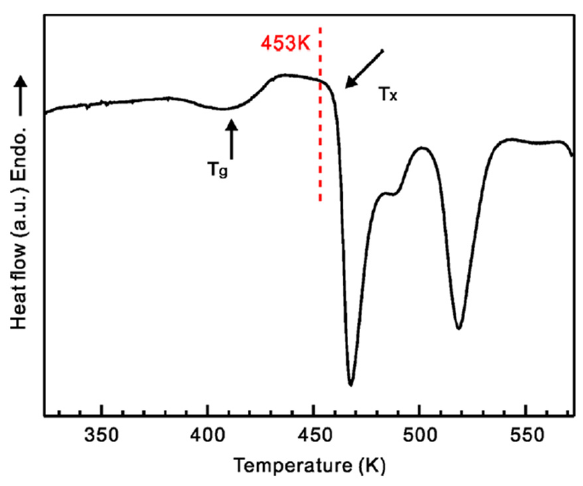
Figure 7. Differential scanning calorimetry scan for the Mg 65 Cu 20 Zn 5 Y 10 metallic glass. Reprinted from [58], Copyright (2014), with permission from Elsevier.